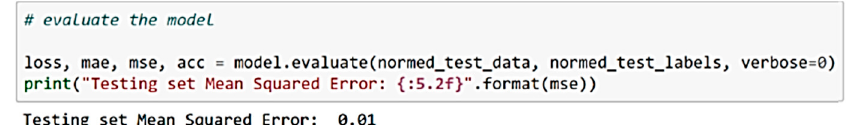
Figure 9. Assessment of the artificial neural network (ANN) with 2 dense layers designed with Keras.